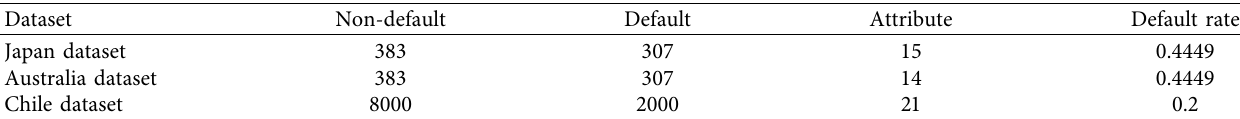
Table 7: Information of datasets.